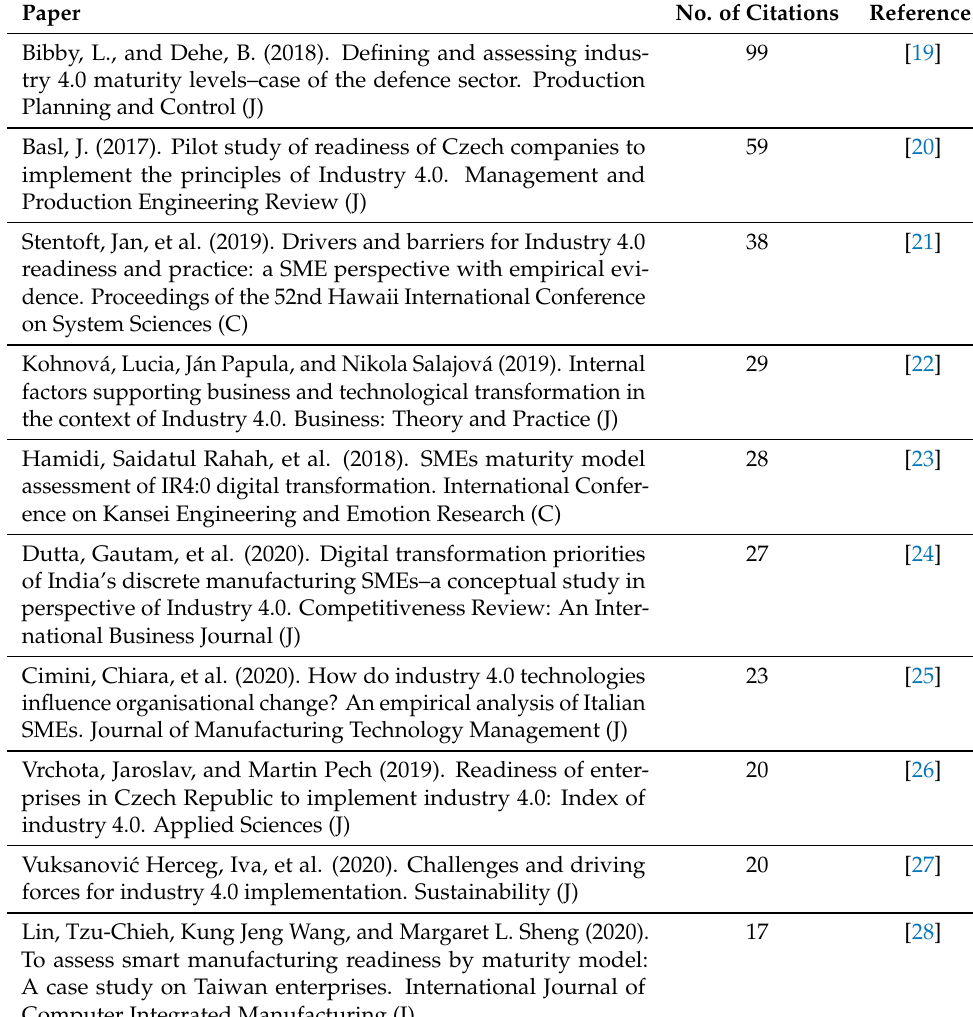
Table 1. Top 10 papers by